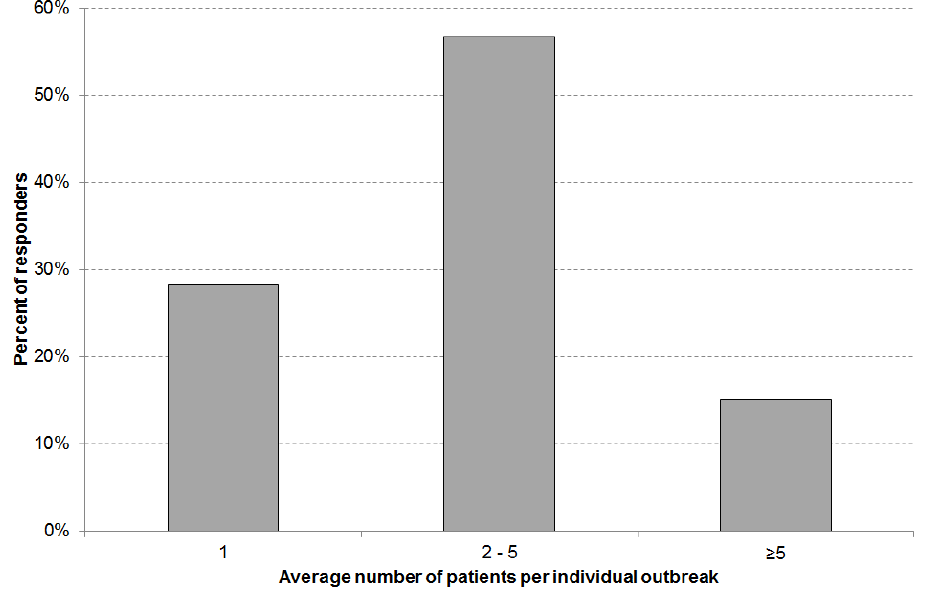
Figure 2. Average number of patients affected by an individual diarrhea outbreak (total number of answers n = 59).